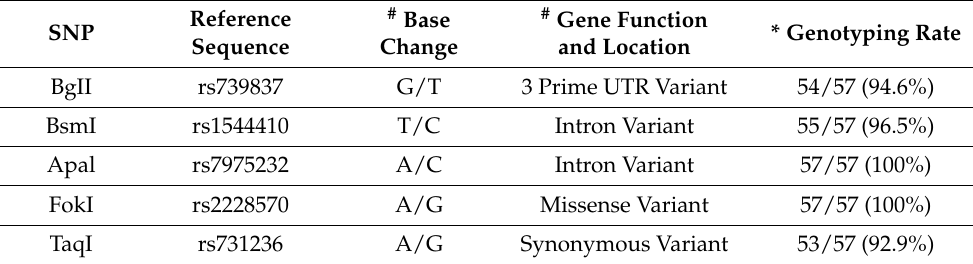
Table 1. Characteristics of the SNPs and genotyping success rate of each SNP.